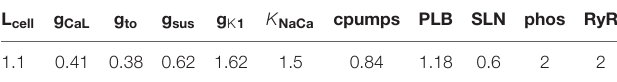
TABLE 2 | Atrial fibrillation electrical